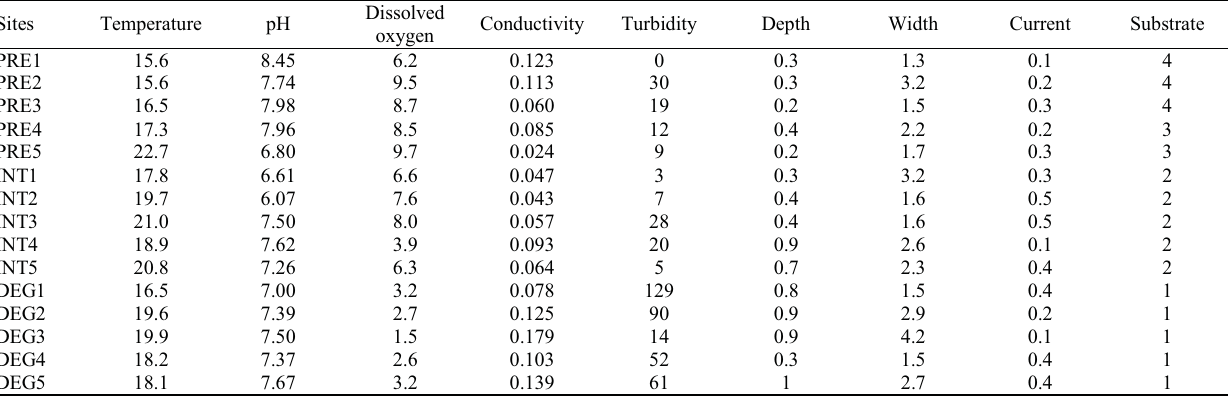
Table 1. Average value of abiotic variables in each site: temperature (ºC), pH, dissolved oxygen (mg/l), conductivity ( μ S/cm 2 ), turbidity (NTU), depth (m), width (m), current (m/s), and predominant substrate (1 = 100-75% sand; 2 = 74-50% of sand and the remaining of consolidated substrate; 3 = 49-25% of sand and the remaining of consolidated substrate; 4 = < 25% of sand and the remaining of consolidated